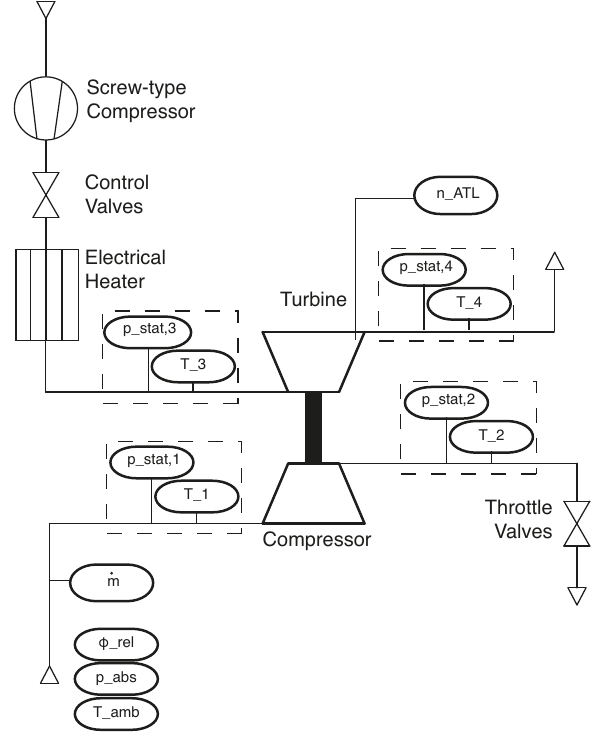
Figure 7. Schematic overview of the turbo charger test rig and measurement planes at TU